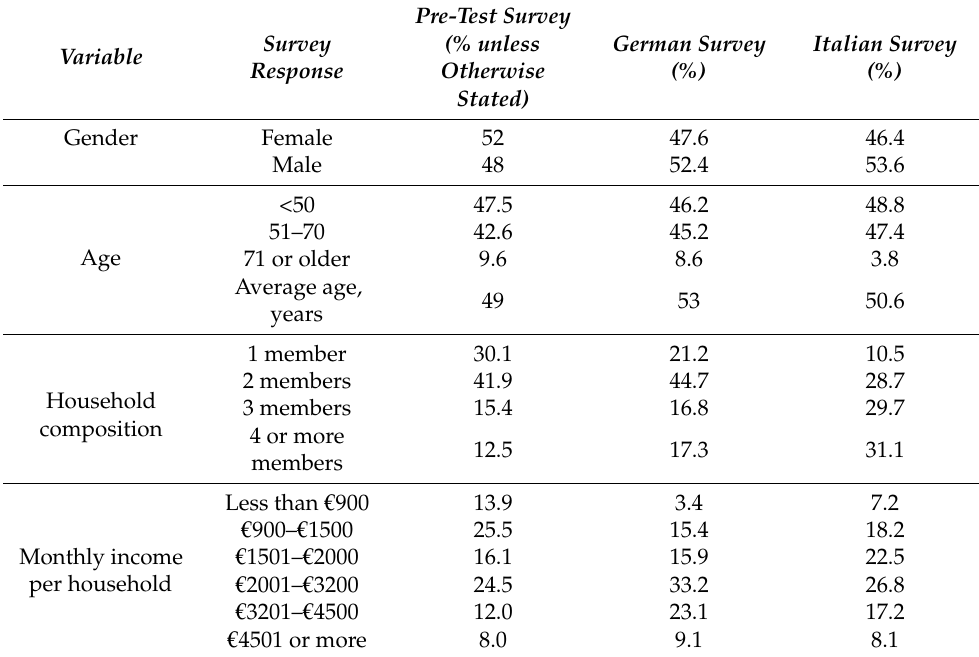
Table 1. Socio-demographics of the pre-test (n = 136), German (n = 208), and Italian (n = 200)